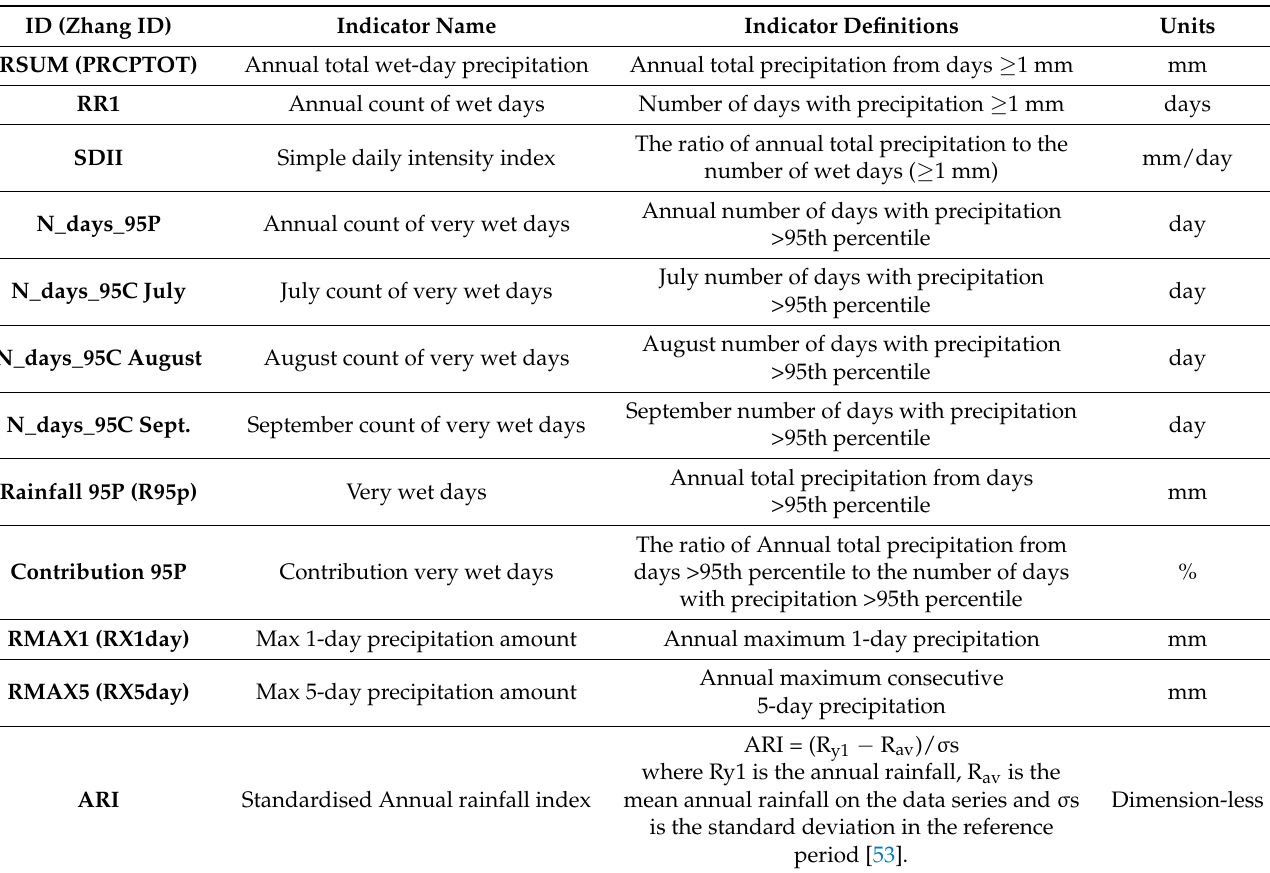
Table 3. Extreme rainfall indices used in this